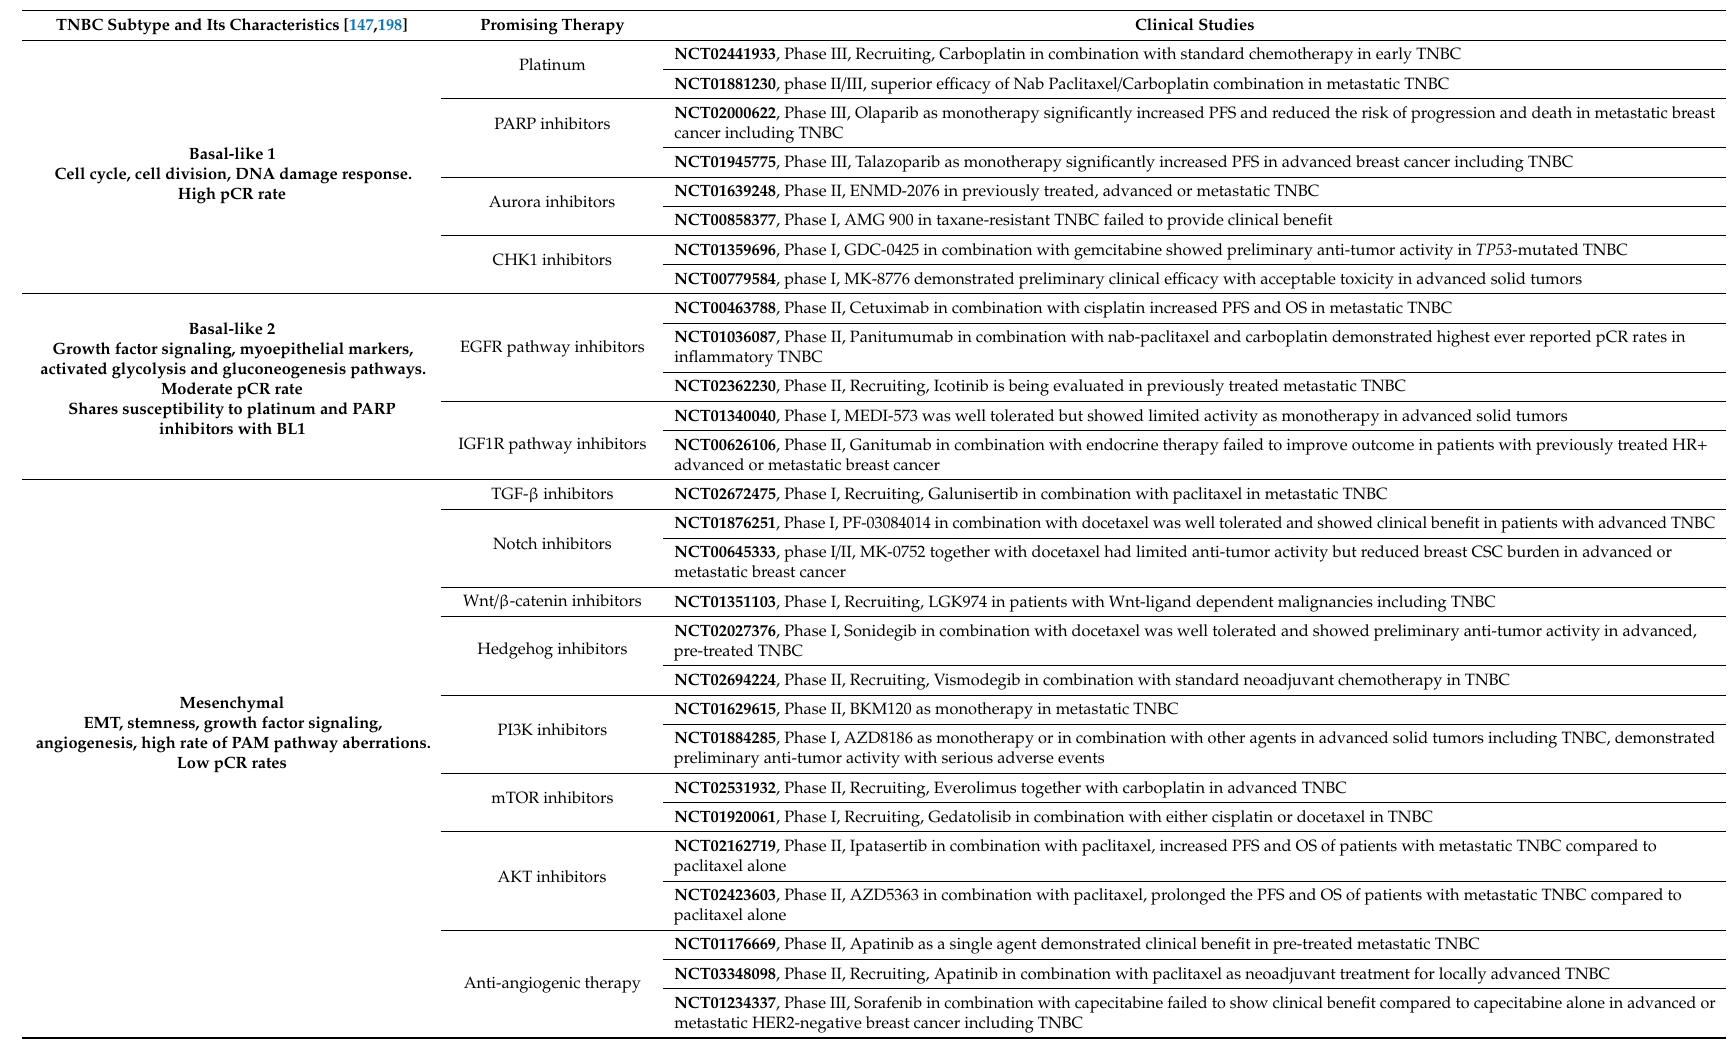
Table 1. Classification of TNBC subtypes and potential therapeutic strategies—recent clinical